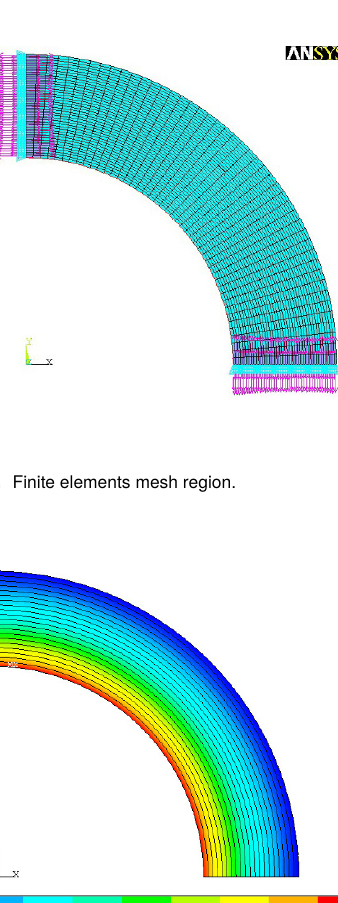
Figure 7. Comparison of stresses in an FGM thick hollow disk ( ξ = 1 . 5 , η = 3) to those in homogeneous thick hollow disk ( ξ = 1) .